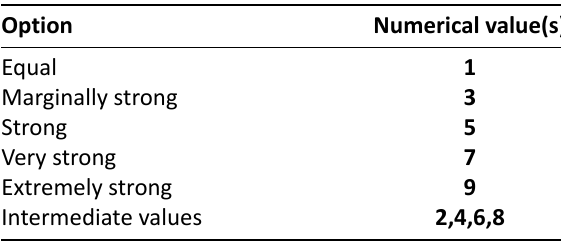
Table 1. Gradation scale for quantitative comparison of